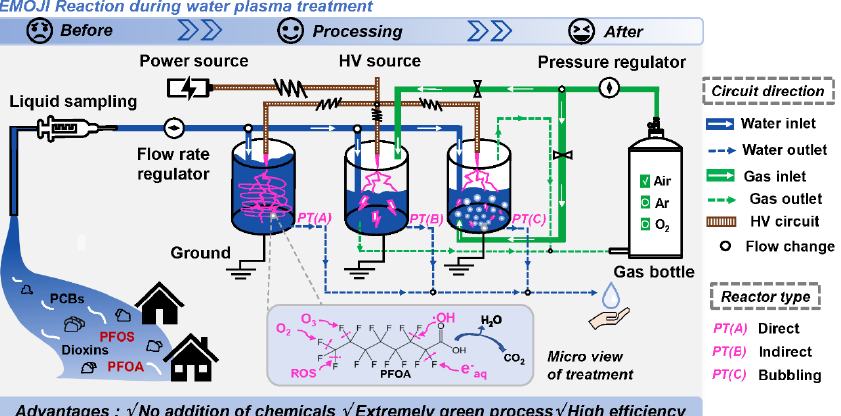
Figure 2. Schematic illustration of plasma technology and its applications in treating different organic pollutants.